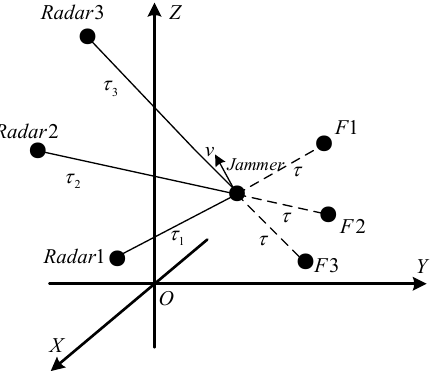
Figure 2. Geometric position distribution of three radars and a jammer.